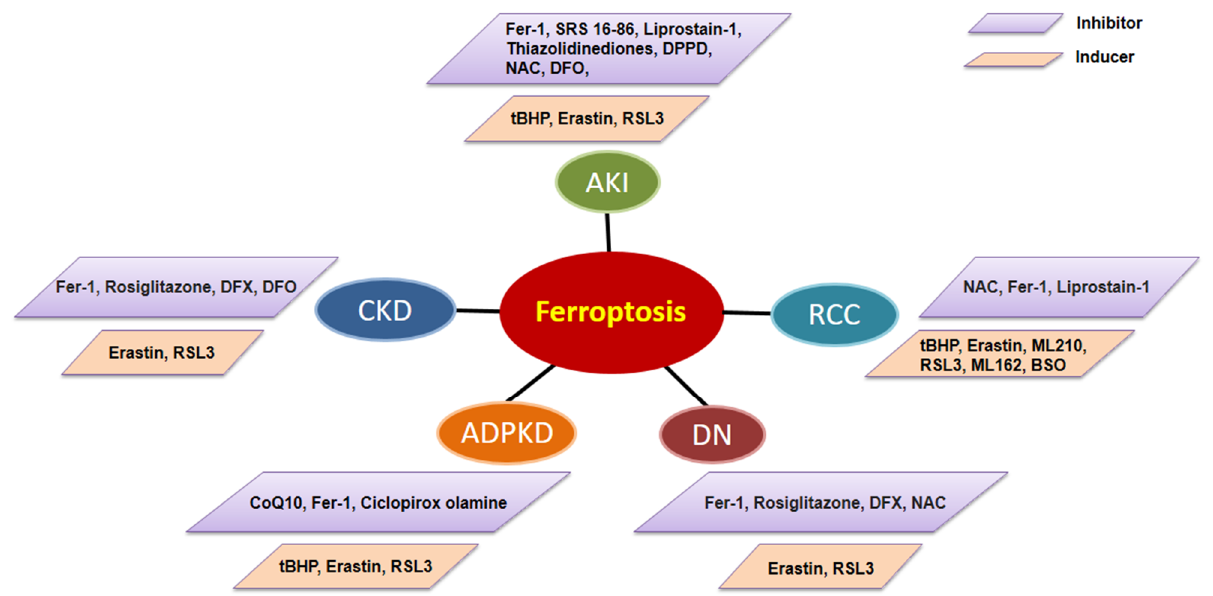
Figure 2. The ferroptosis inducers and inhibitors used/tested in animal models of kidney disorders, including AKI, DN, CKD, ADPKD, and RCC. AKI: acute kidney injury; DN: diabetic nephropathy; CKD: chronic kidney disease; ADPKD: autosomal dominant polycystic kidney disease; RCC: renal cell carcinoma. Fer-1: Ferrostain-1; DPPD: diphenyl-p-phenylenediamine; NAC: N-acetyl-l-cysteine; ferric ammonium citrate, DFO: deferoxamine mesylate; Rosiglitazone: the inhibitor of ACSL4; DFX: deferasirox; CoQ10: Coenzyme Q10; BSO: L-buthionine (S,R)-sulfoximine.